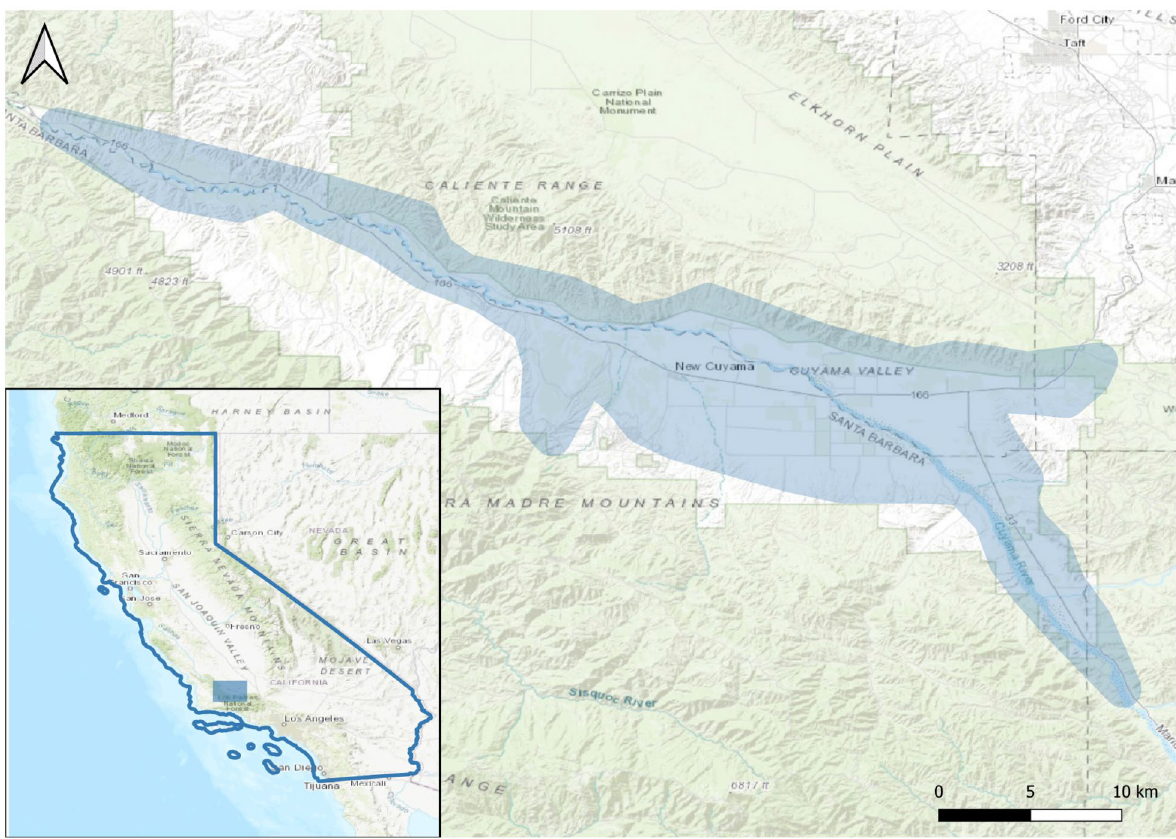
Figure 1. A map of Cuyama Valley in Central California drylands. This region is situated within the San Joaquin Desert of California between two inland mountain ranges. It is a major hydrological catchment with agriculture, energy developments, and extant native vegetation and animal species. All instances of remnant native Ephedra californica parklands with shrubs present and intact were sampled. Sets of shrubs and open, interstitial microsites were instrumented for assessment of microclimate changes regionally. All sites were located on the valley floor and were adjacent to anthropogenic disturbances such as agriculture, energy developments, or farms—but were mostly native patches of relict vegetation. The map of Cuyama Valley was rendered using Quantum GIS open-source software (www. qgis. org) version 3.12.1. The shaded relief map was from ESRI Topographical Maps (www. ESRI.